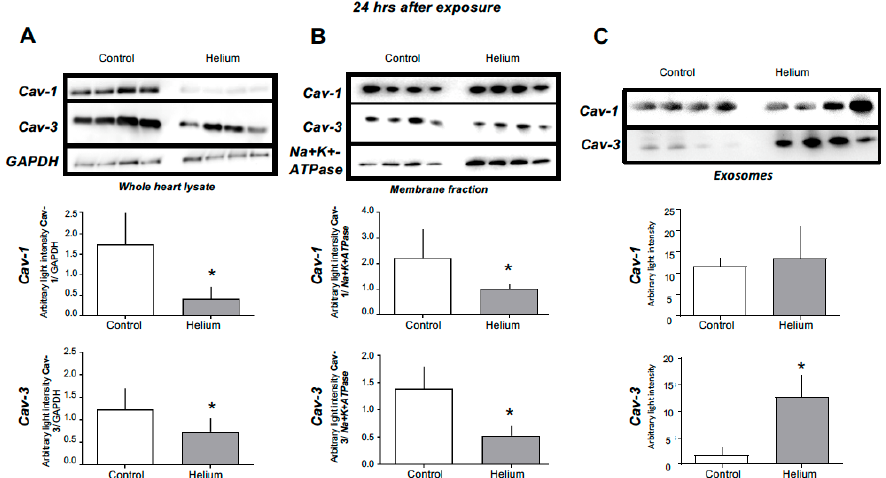
Figure 3. Cav-1 and Cav-3 levels in di ff erent tissues at the 24-h time point. ( A) Cav-1 and Cav-3 levels were significantly lower in He whole-heart tissue of helium-treated mice, measured by western blot analysis. ( B ) Cav-1 and Cav-3 levels were significantly lower in membrane fractions of He-treated mice, measured by western blot analysis, n = 4. ( C ) Cav-3 levels were significantly higher in exosomes isolated from PFP of He-treated mice, measured by western blot analysis n = 4. Data are shown as mean ± SD, p < 0.05 was considered statistically significant. As Cav-1 and Cav-3 levels are lower in whole-heart lysate and membrane fractions but higher in exosomes of PFP at the same time point, these data suggest a secretion of Cav-1 and Cav-3 from cellular membranes located in the heart into the